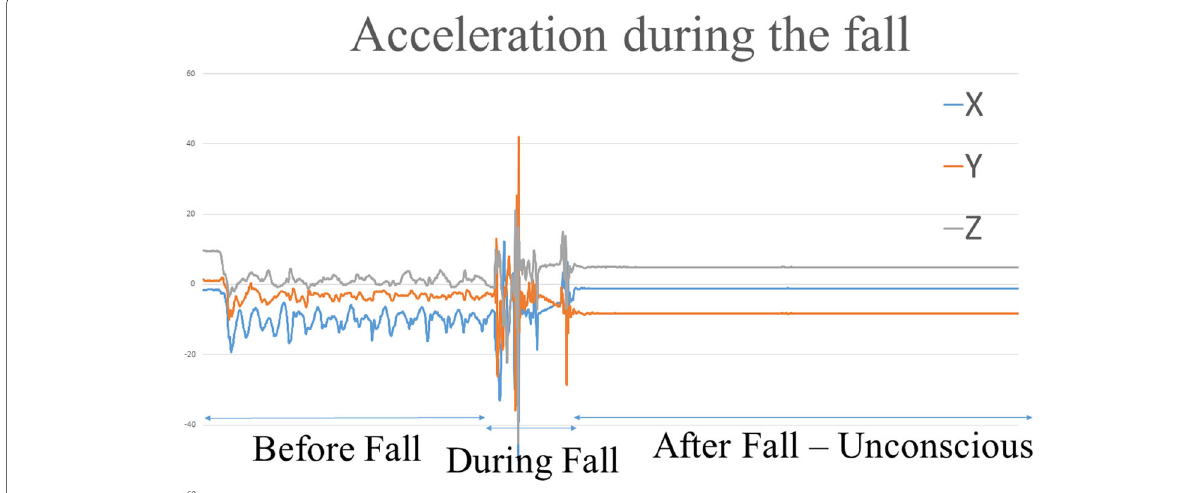
Fig. 2 Fall pattern measured with accelerometer. Before the fall, the movement is normal ; during the fall, the y and z axes change positions; after the fall the person is lying still—therefore no movement is